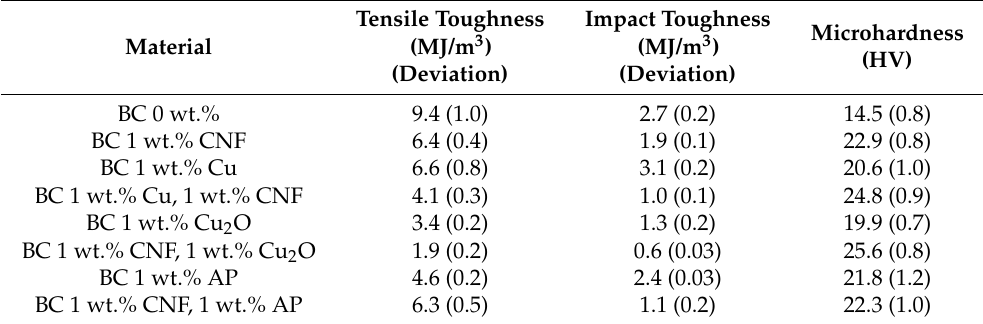
Table 3. Toughness calculated (MJ/m 3 ) and deviation for all materials, Impact strength (kJ/m 2 ) and deviation for all materials, and Vickers-microhardness (HV) and deviation for all